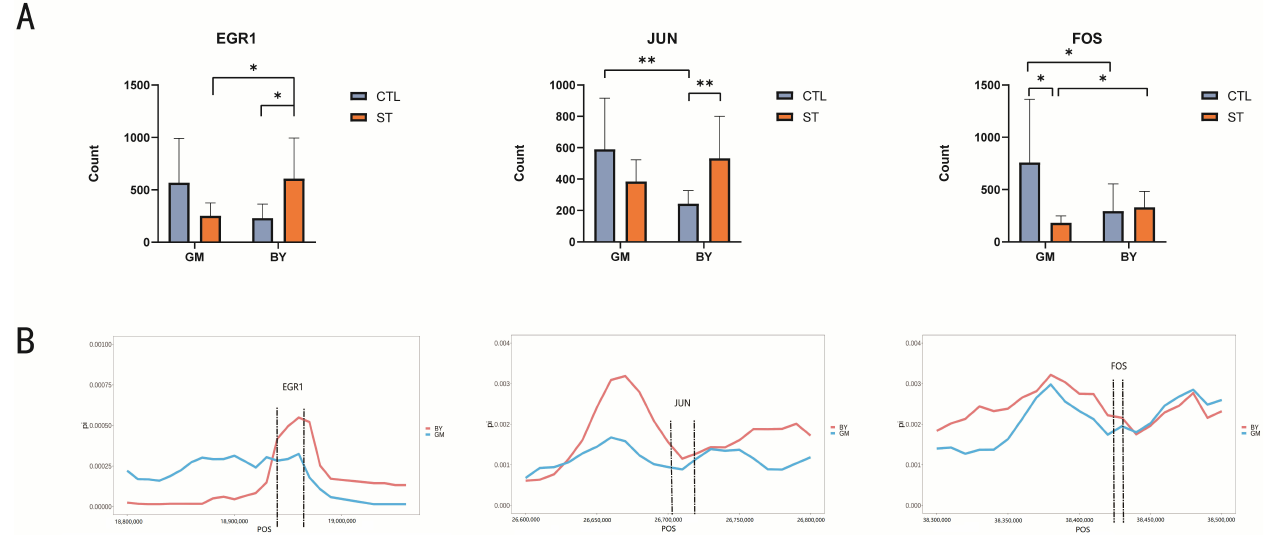
Figure 6. Genome-wide selection signal analysis of three genes in BY and GM; blue line represents GM and red line represents BY. ( A ) Comparison of Count values of three genes before and after Salmonella infection in two breeds. ( B ) Fold diagram of the selection signal for the three candidate gene genes of BY and GM. * ( p < 0.05); ** ( p <